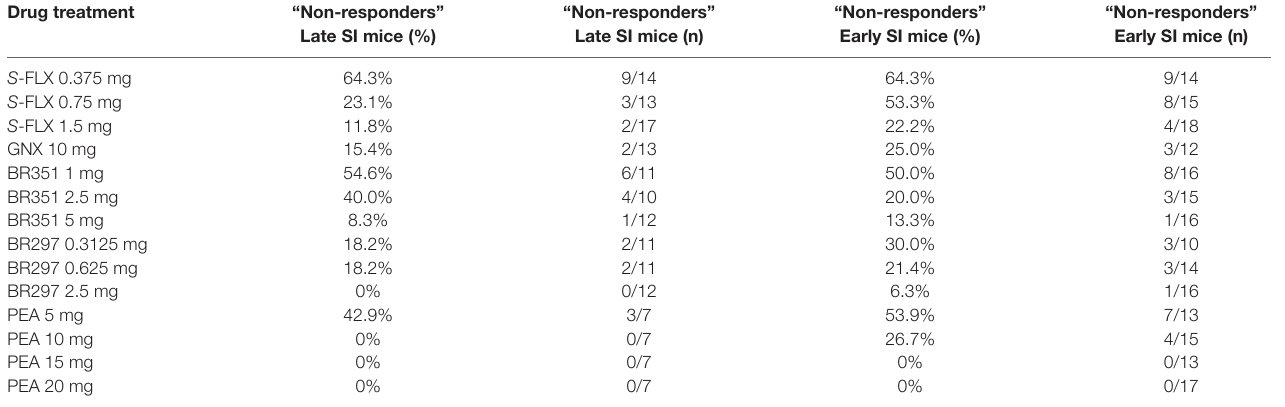
TABLE 1 | Rate of adolescent SI mice that show resistance to the single administration of S -fluoxetine ( S -FLX), ganaxolone (GNX), BR351, BR297, and PEA. Drug treatment “Non-responders”